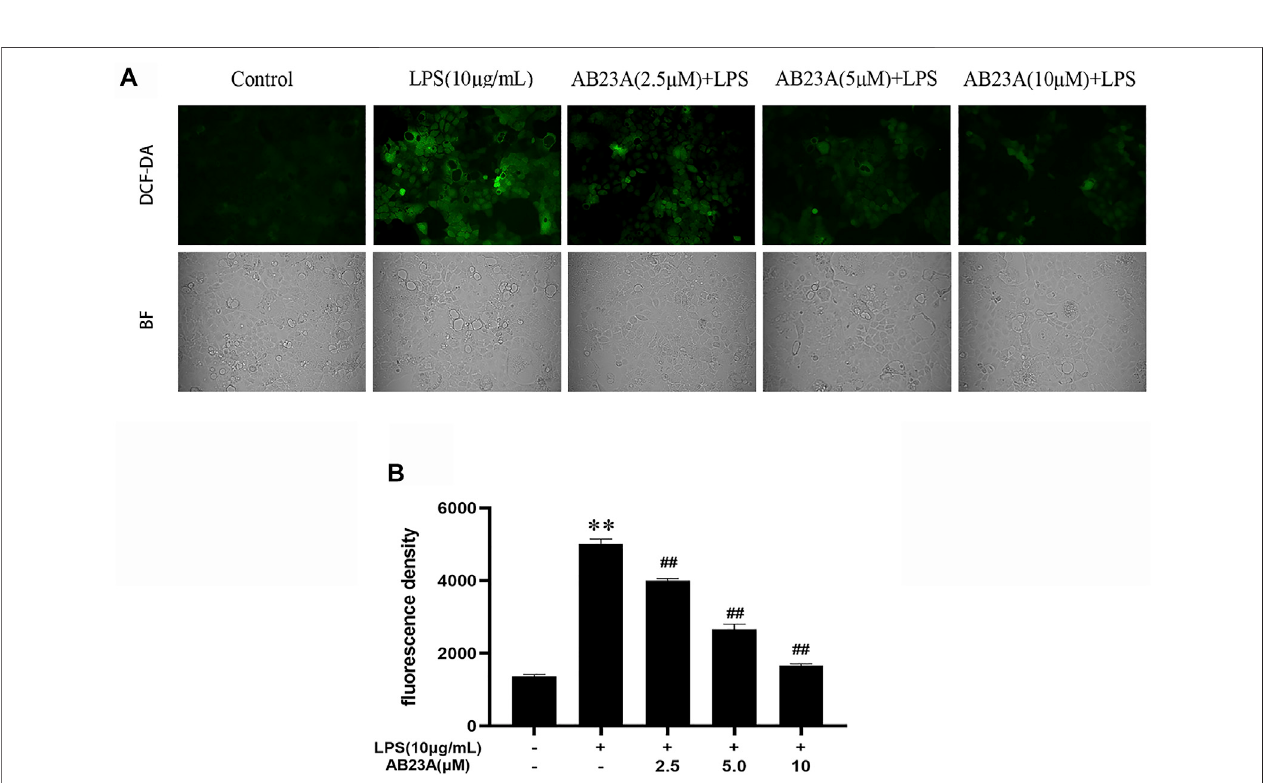
FIGURE3| AB23AeffectontheROSgenerationinducedbyLPS.Caco-2cellsunderwenttreatmentwithAB23Aconcentrations(2.5,5and10 μ M)withorwithout 10 μ g/ml LPS for 12 h. (A) Utilizing a fl uorescent microscope, intracellular ROS was noticed, and the corresponding cell morphology was captured utilizing a bright fi eld (BF) (magni fi cation, ×10). (B) ROS were detected under a multifunctional microplate reader. ** p < 0.01 vs. control; ## p < 0.01 vs. LPS (10 μ g/ml).